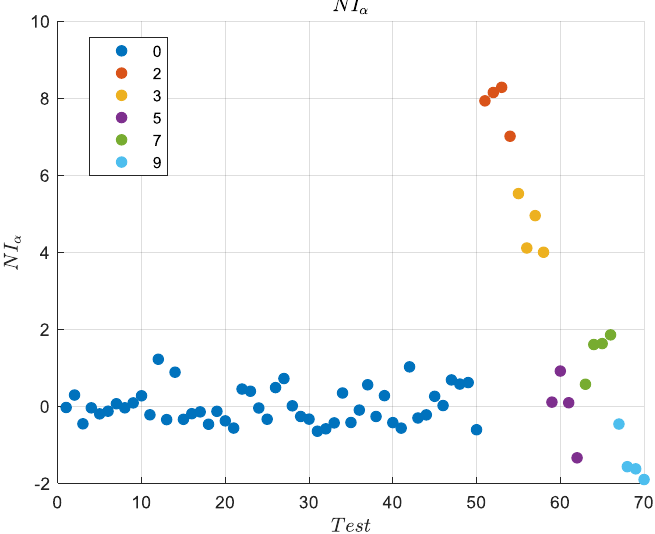
Figure 4. Linear Combination NI α . Healthy conditions of the machinery are indicated as Class 0, while the damage is defined as Class k , where k = 2, 3, 5, 7, 9.